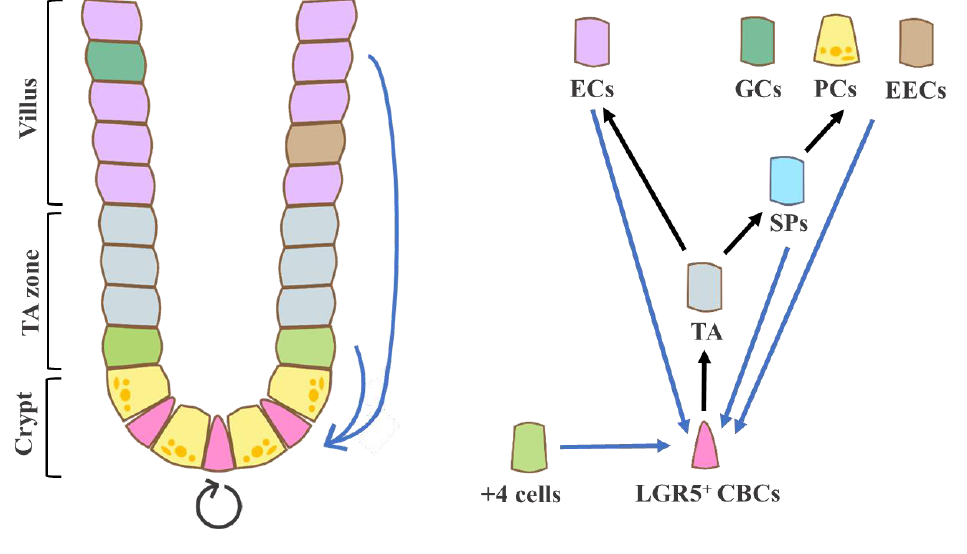
Figure 1. The intestinal crypt – villus structure and cell specification of intestinal stem cell (ISC)-differentiated intestinal epithelial cells (IECs) during homeostatic conditions (black arrow) and injury-induced cellular reprogramming (blue arrow). CBCs, crypt base columnar cells; TA, transit-amplifying cells; SPs, secretory precursors; ECs, enterocytes; GCs, goblet cells; PCs, Paneth cells; EECs, enteroendocrine cells.